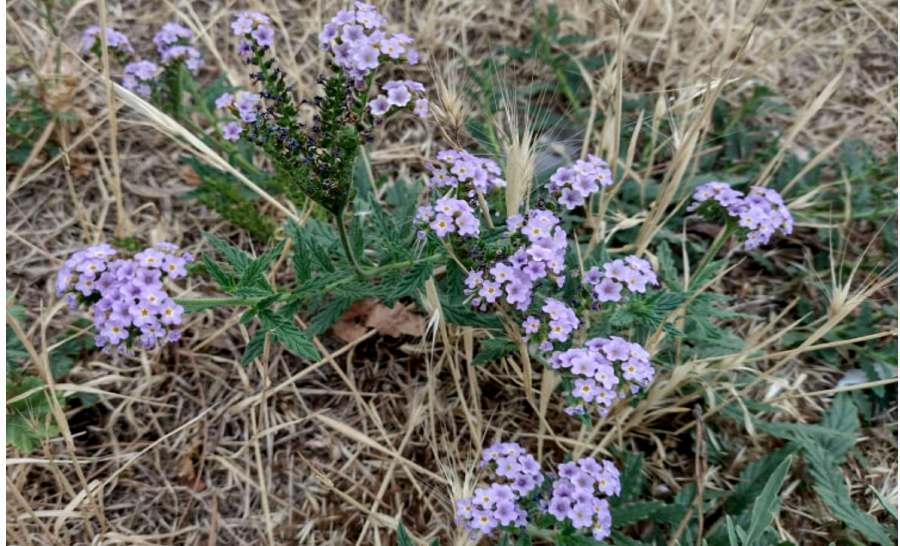
Figure 47. Heliotropium amplexicaule in the central reservation of Appia Nuova